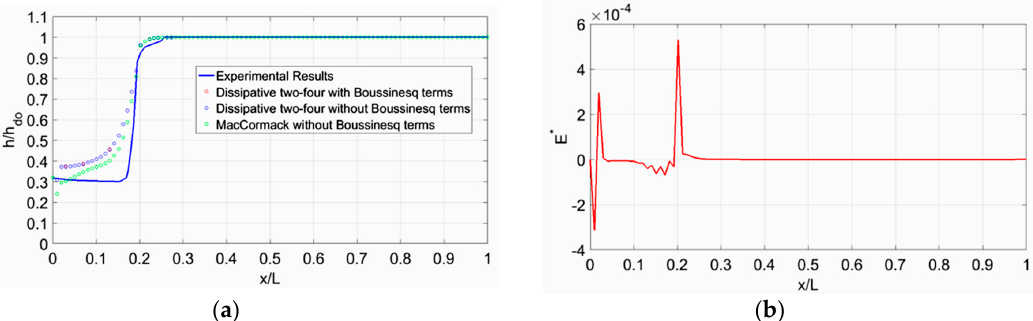
Figure 2. Experimental and Numerical Results for test case 1: ( a ) Free surface profile; ( b ) Boussinesq term versus distance.